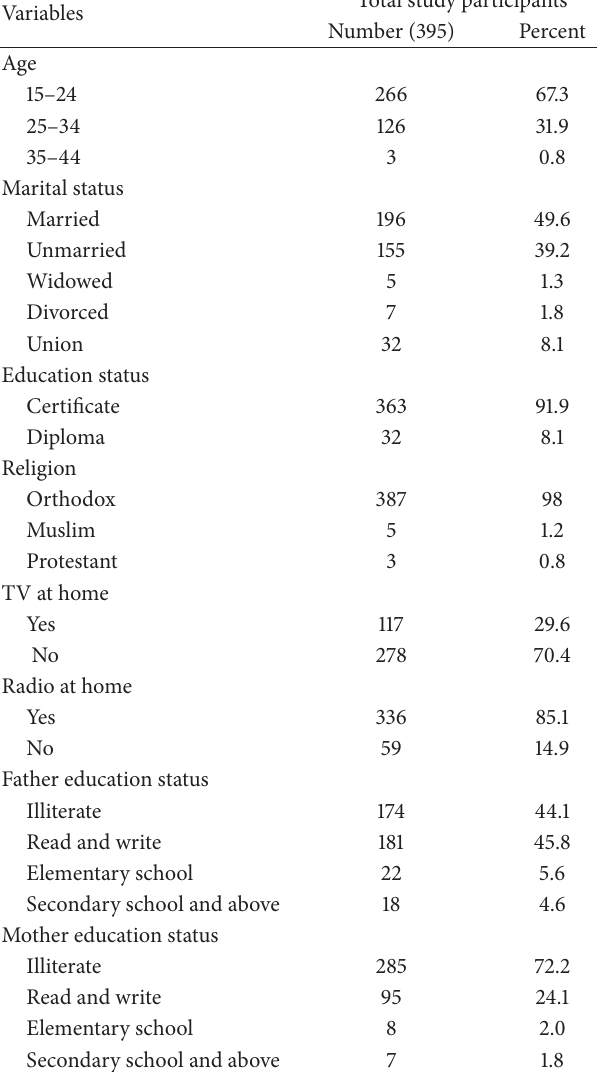
Table 1: Sociodemographic characteristics of health extension workers in West Gojjam Zone, Northwest Ethiopia, October